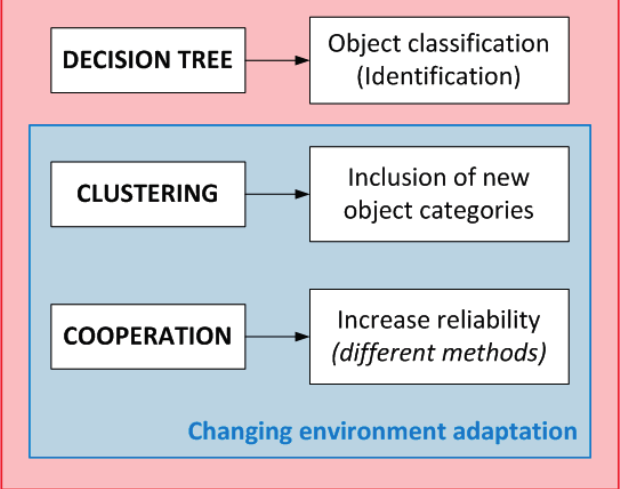
Figure 2. Identification process combining different machine learning methods and